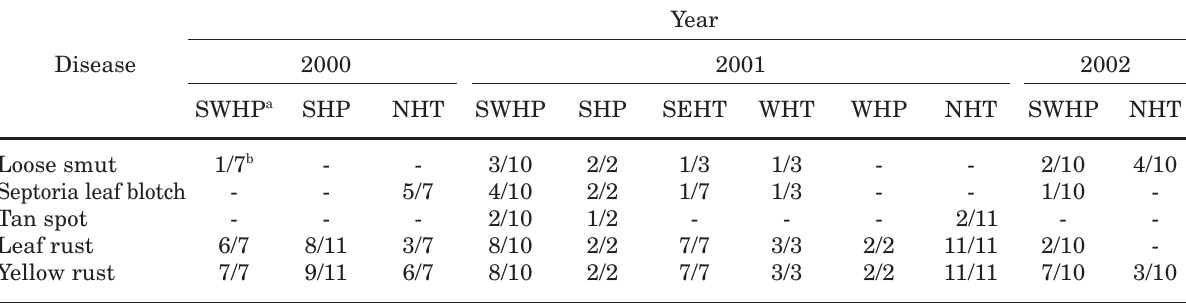
Table 3. Main wheat diseases in Eritrea in 2000–2002.